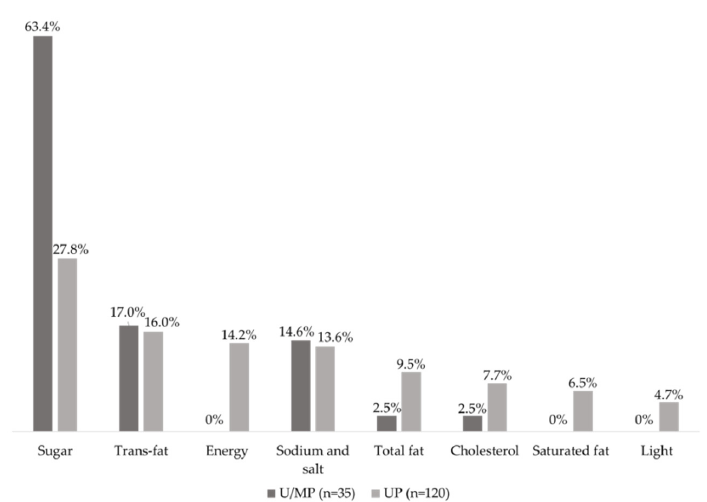
Figure 1. Distribution of Complementary Nutritional Information about ‘reduced content’ or ‘absence’ of different nutrients in the analysed products. Legend: U/MP = Unprocessed/Minimally Processed foods. UP = Ultra-processed foods.